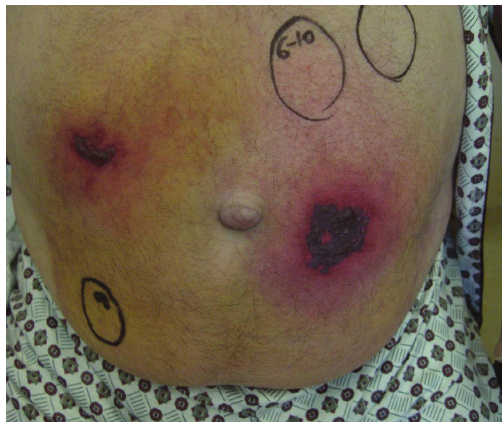
Figure 1: Macroscopic appearance of the